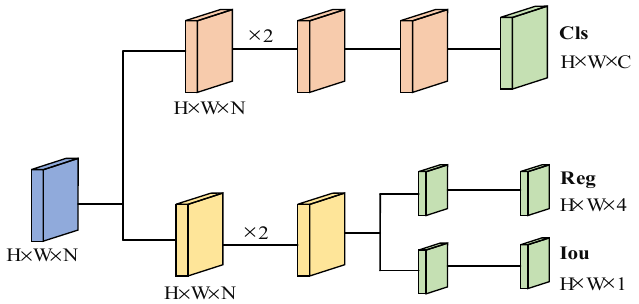
Figure 7. YoLoX-Nano Decoupled Head.